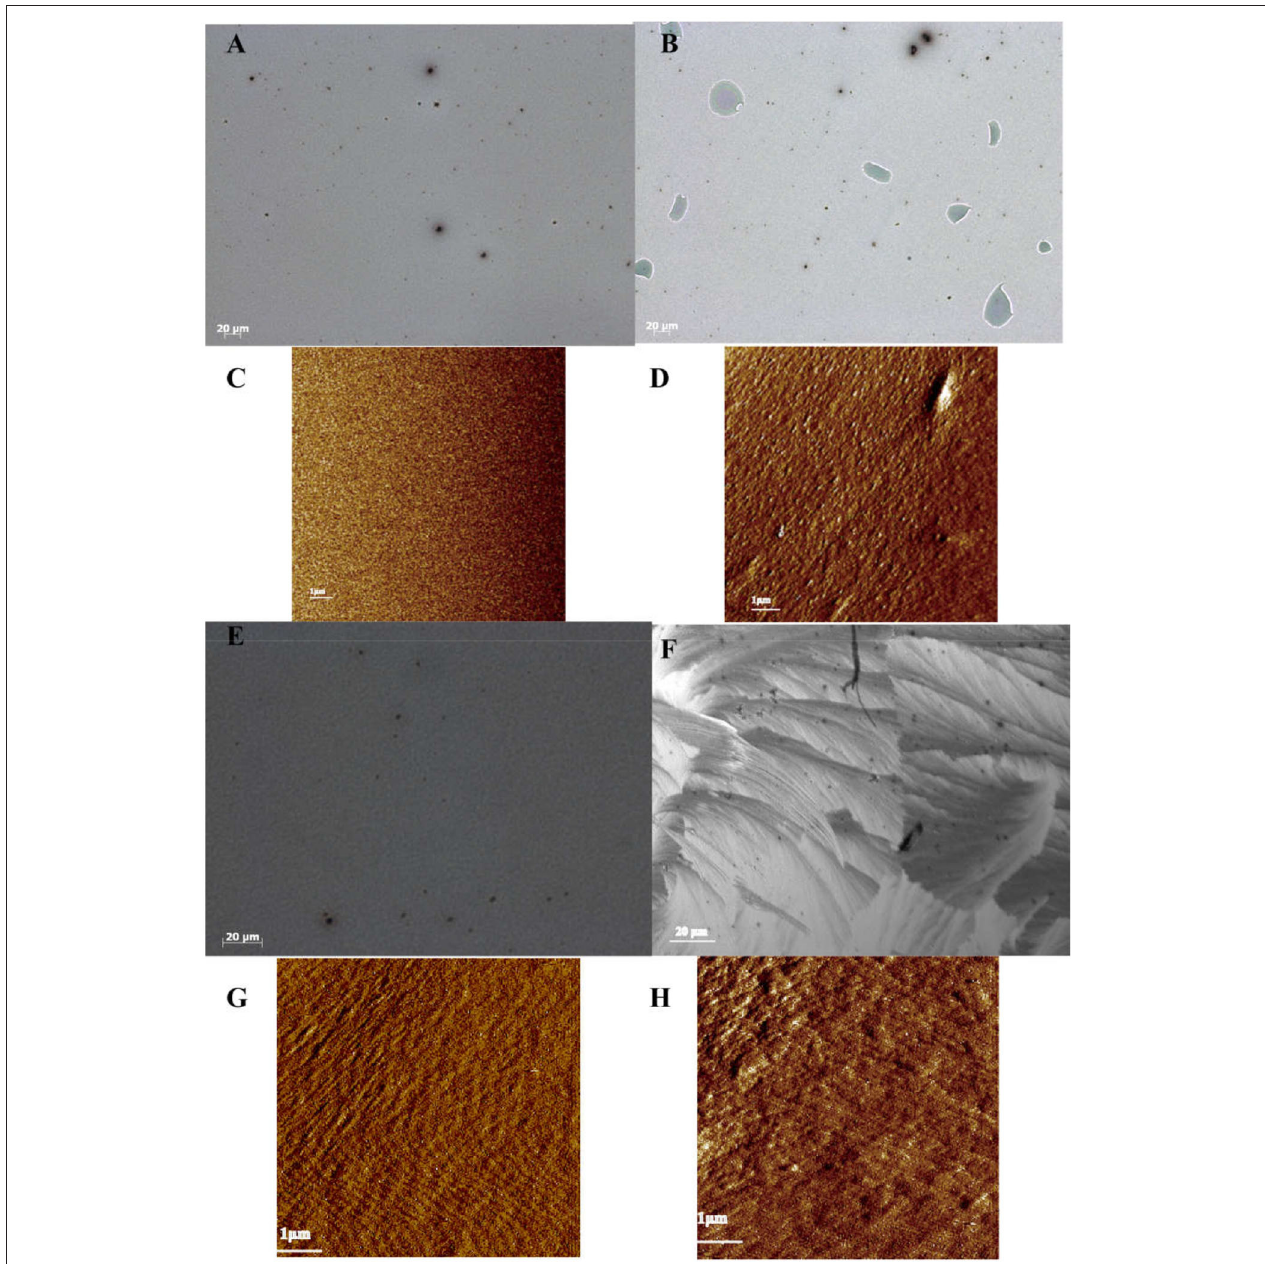
FIGURE 4 | High-resolution optical microscope of PEDOT:PSS surfaces processed (A) in glove-box and (B) in air; AFM images of PEDOT:PSS surfaces processed (C) in glove-box and (D) in air; OM images of p-DTS(FBTTh 2 ) 2 :PC 71 BM surfaces (E) in glove-box and (F) in air; AFM images of p-DTS(FBTTh 2 ) 2 :PC 71 BM surfaces processed (G) in glove-box and (H) in